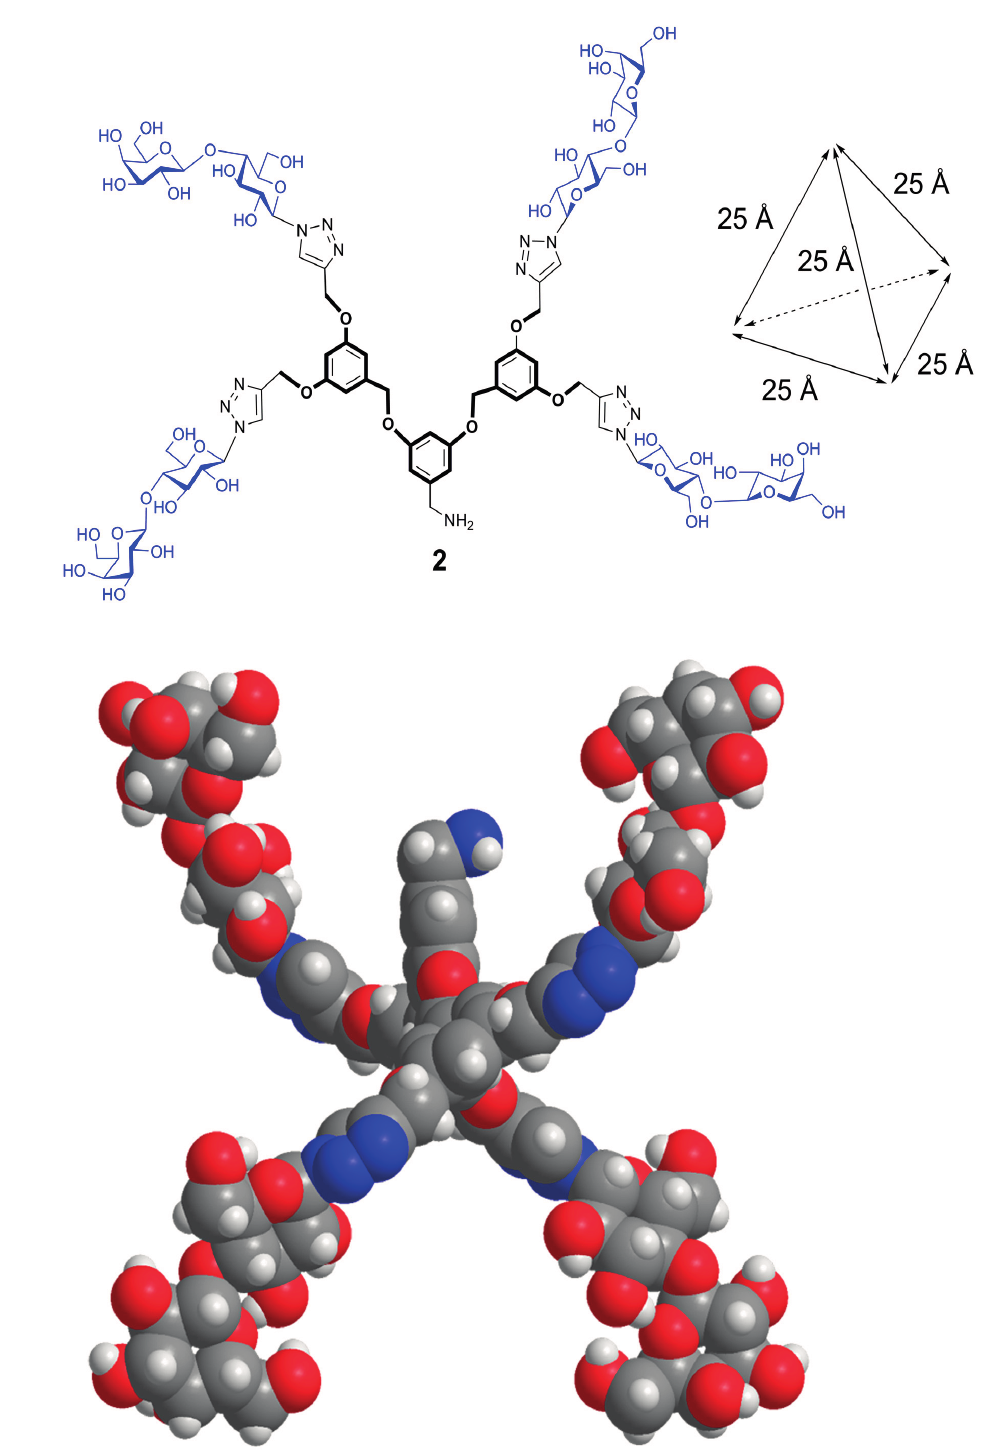
Figure 14. Distance profile of a conformer of the tetravalent glycocluster 2 with tetrahedral branch arrangement. As noted above for the trivalent compound, dynamic fluctuations in space and time will alter the distance profile to a limited